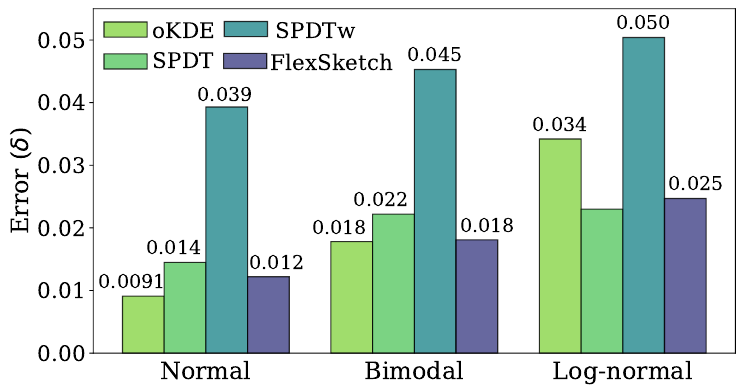
Figure 5. Estimation error ( δ ) for stationary data streams (a smaller value is better). The error of FlexSketch for the bimodal distribution is 0.018, which is 0.98 ˆ , 1.2 ˆ , and 2.5 ˆ smaller than those of oKDE , SPDT , and SPDTw , respectively. oKDE using